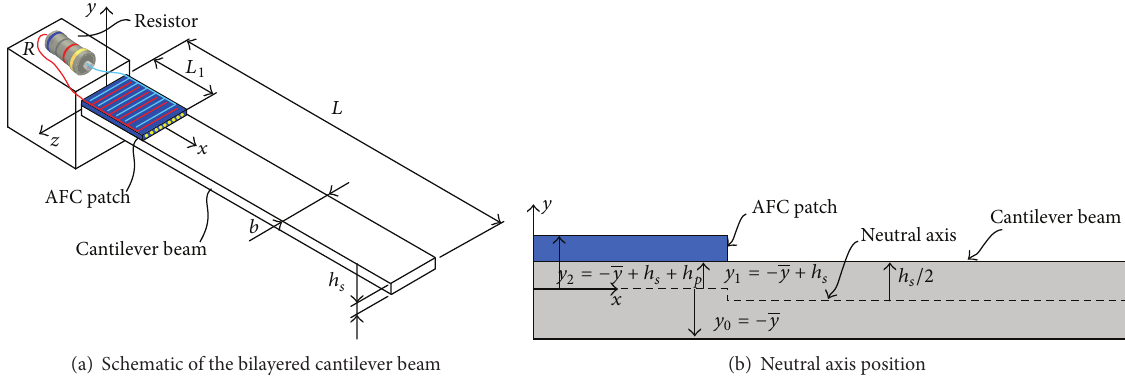
Figure 4: Schematic of the energy harvester with its neutral axis position. Table 3: Material and geometrical properties of the bi-layered cantilever